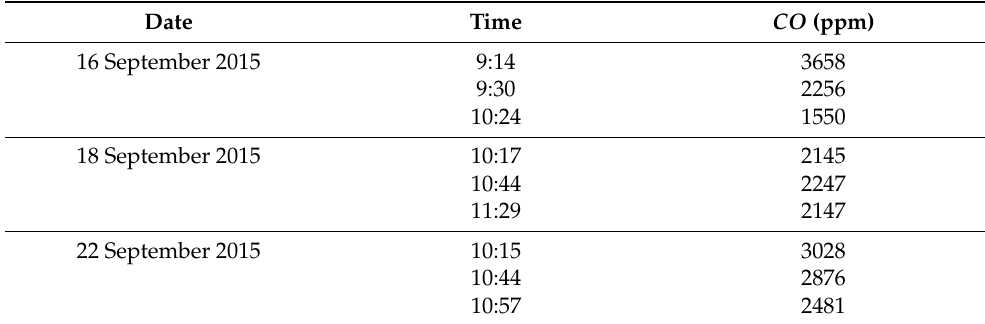
Table 1. Measured carbon monoxide ( CO ) concentration in ppm within flue gases of the blast furnace provided by CCT